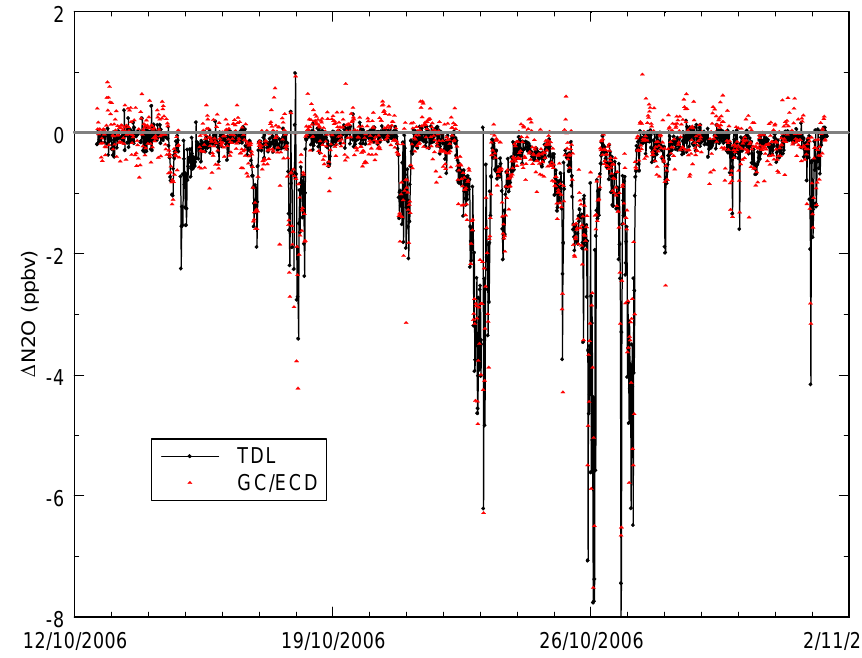
Fig. 4. Timeline of N 2 O vertical gradient mixing ratio difference for TDL and GC.